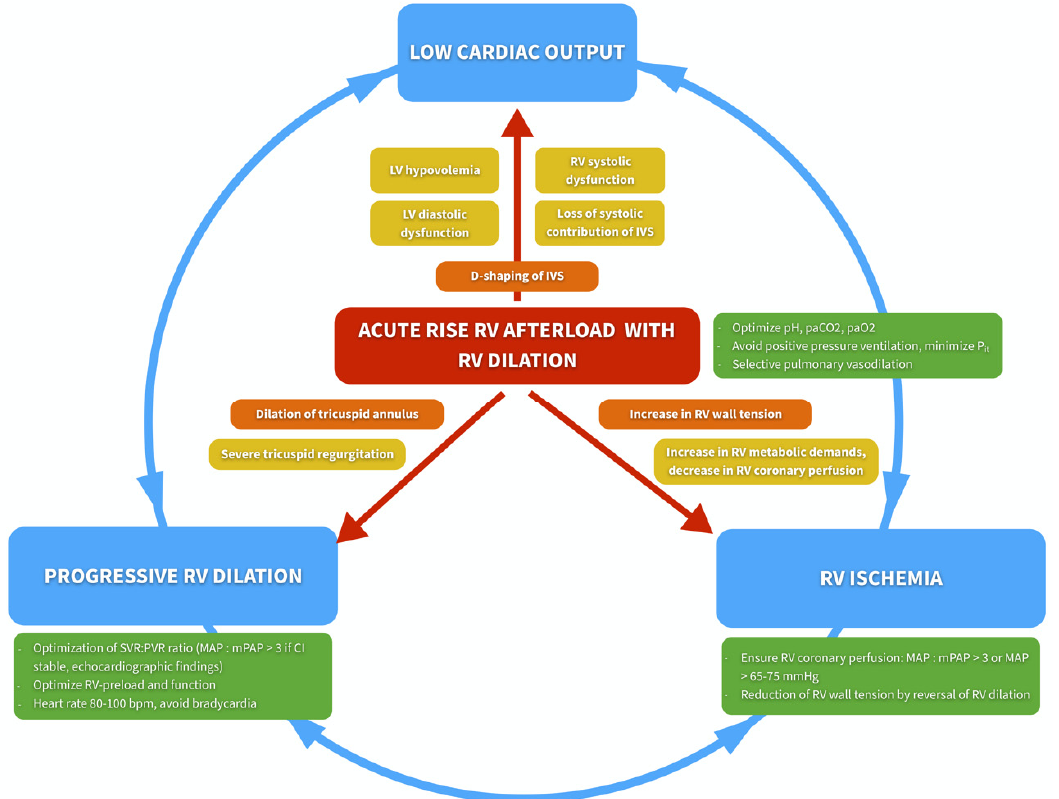
Figure 2. Vicious circle of right ventricular failure. Abbreviations: CI, cardiac index; IVS, interventricular septum; LV, left ventricular; MAP, mean arterial pressure; mPAP, mean pulmonary artery pressure; P it , intrathoracic pressure; PVR, pulmonary vascular resistance; RV, right ventricular; SVR, systemic vascular resistance. Modified from Wanner PM & Filipovic M. (Der rechte Ventrikel— das Wichtigste für den Intensivmediziner. In: Eckart, Forst, Briegel, eds.: Intensivmedizin. Kompendium und Repetitorium zur interdisziplinären Weiter ‐ und Fortbildung. ecomed Verlagsgesellschaft AG & Co., Landsberg. 2018) [12].